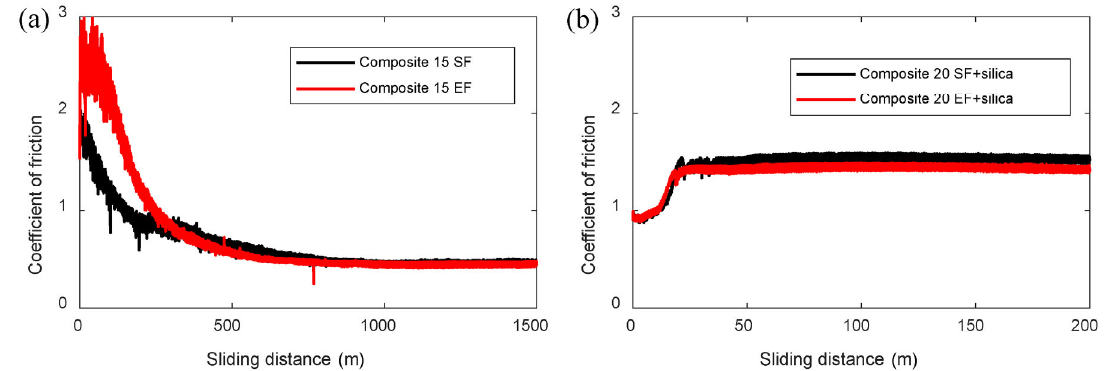
Fig. 5 Coefficients of friction as a function of sliding distance for: (a) composite 15 SF vs. composite 15 EF at a contact pressure of 0.2 MPa, (b) composite 20 SF+silica vs. composite 20 EF+silica at a contact pressure of 0.68 MPa. All composites have randomly oriented